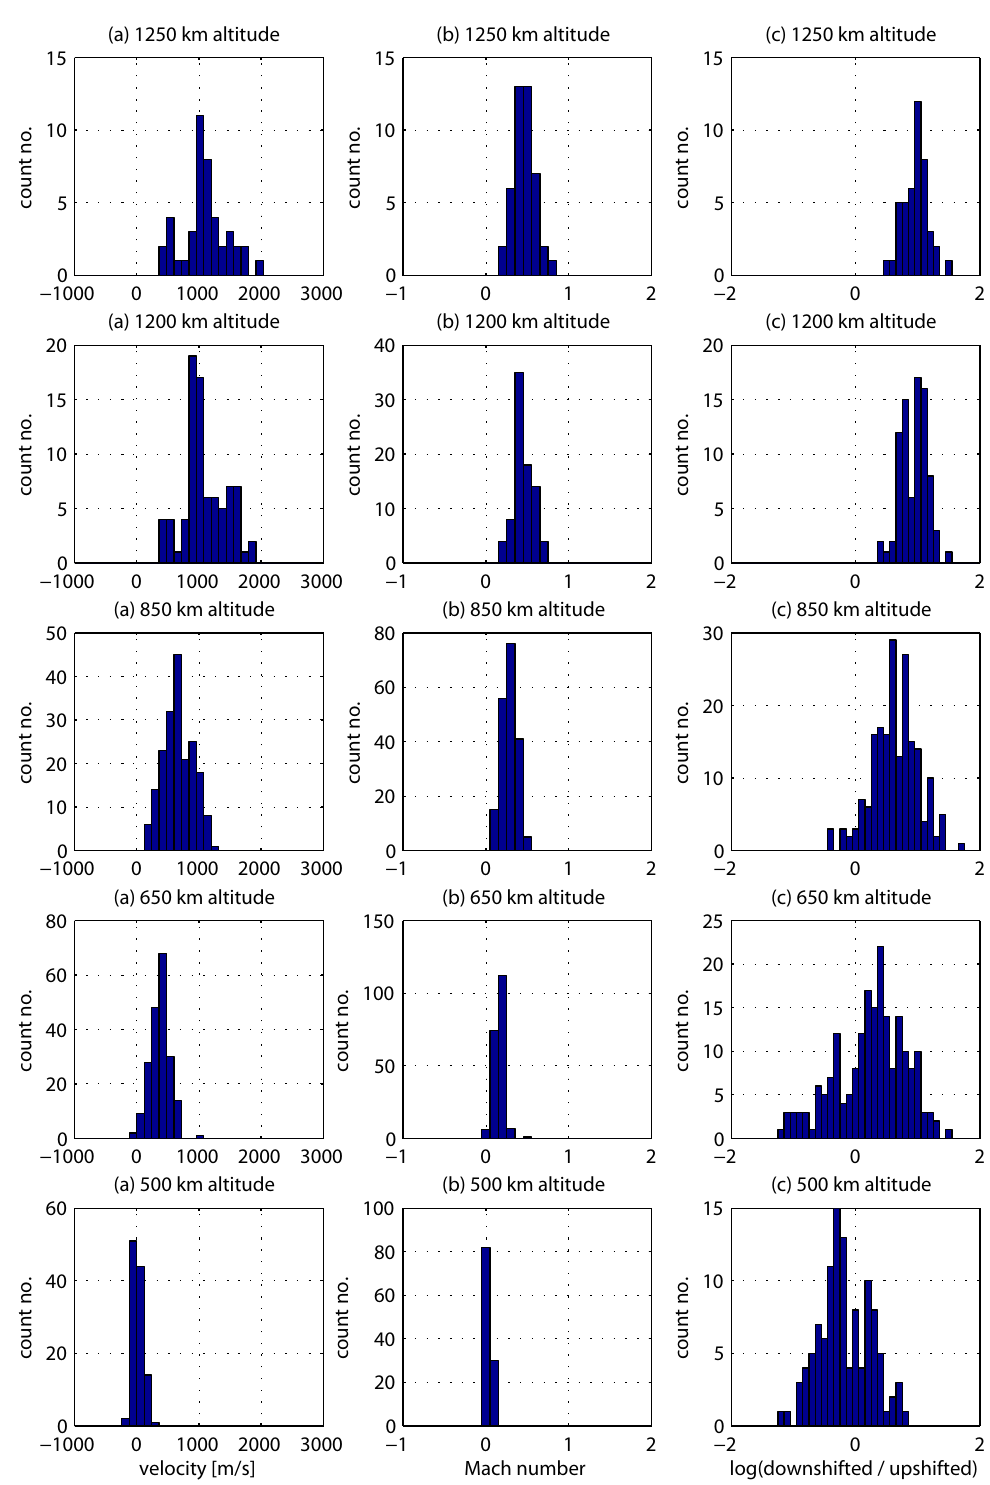
Fig. 7. Fig. 7. Histograms of NEIAL parameters at altitudes of 500, 650, 850, 1200, 1250km from 09:00 to 11:30 UT on 28 July 2000. The altitude span of the gates is 50km. (a) Doppler velocity. (b) Estimated Mach number. (c) Ratio of the downshifted to upshifted peak